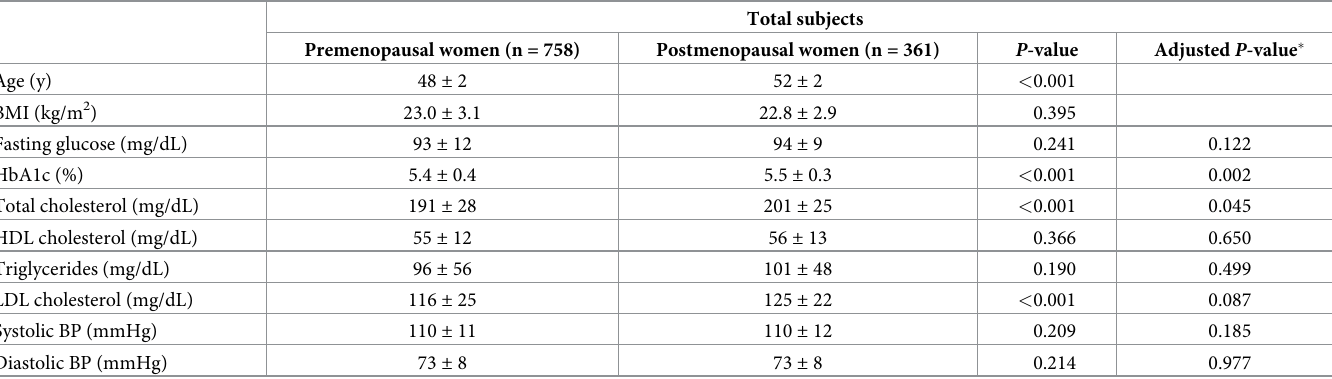
Table 1. Baseline characteristics of study